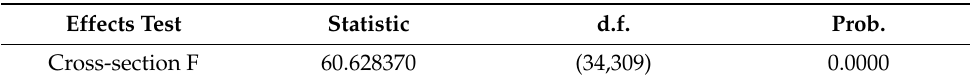
Table 5. The results of likelihood ratio test.